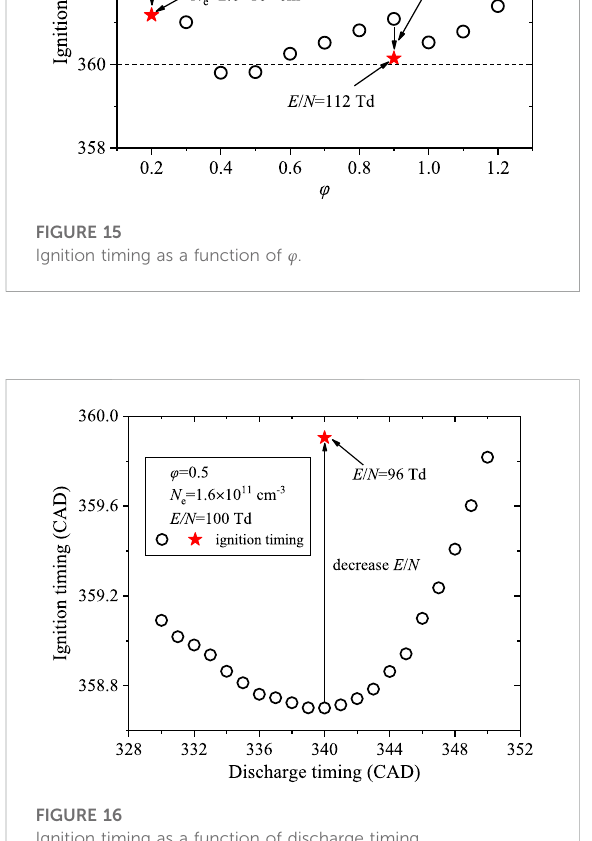
FIGURE 16 Ignition timing as a function of discharge